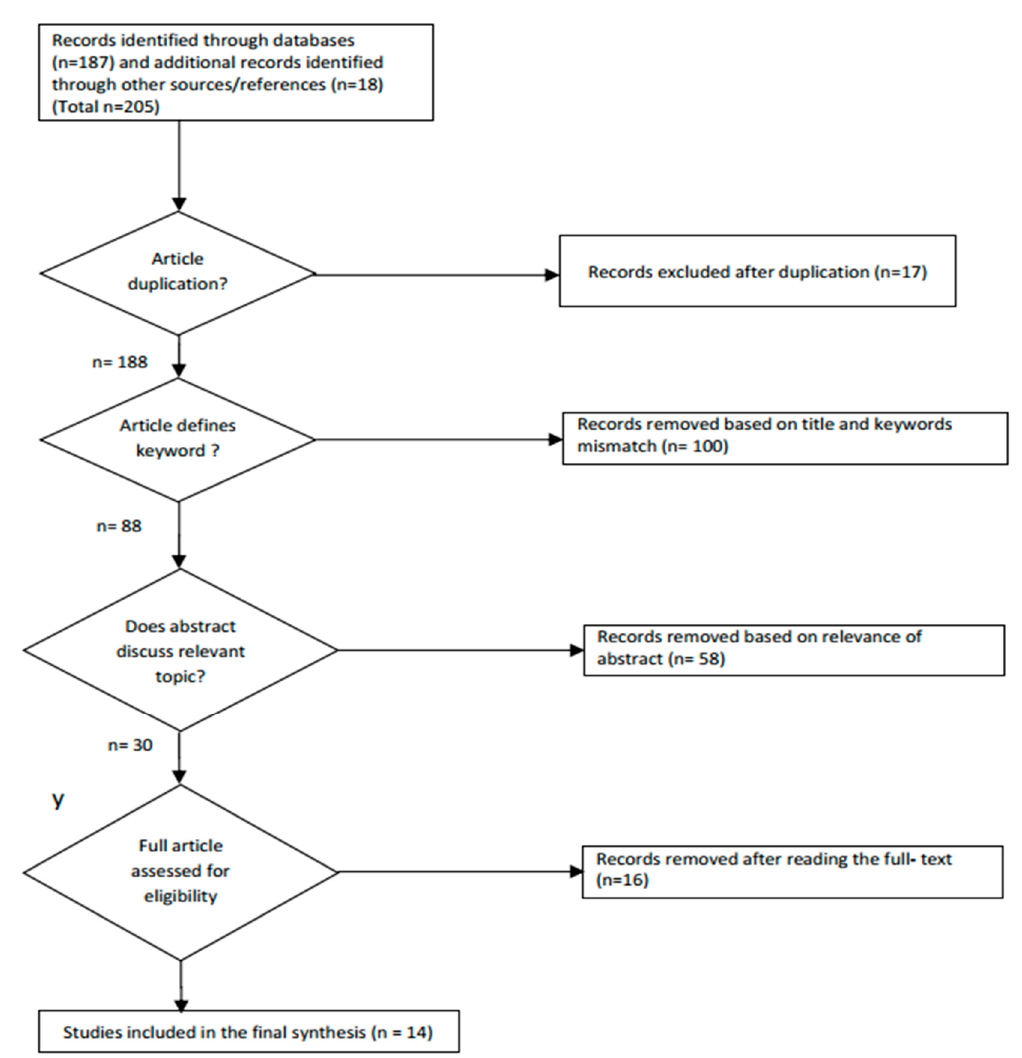
Figure 1. PRISMA diagram used during the systematic literature review.